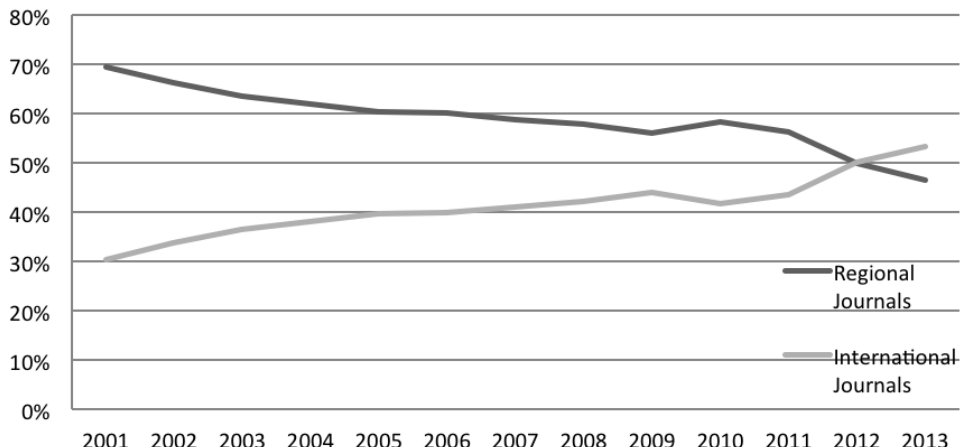
Figure 3 . Where Brazilian Authors Publish: